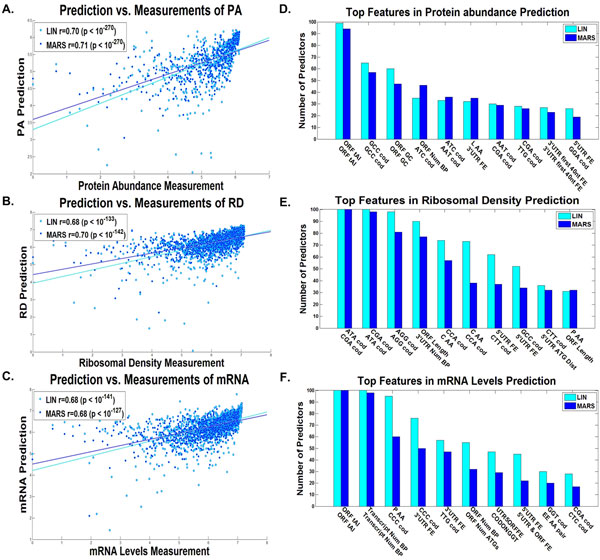
Entire Transcript linear and non-linear predictors results. Dot plot of the predictions vs. measurements for the validation set of the predictor with the median results for the A. protein levels, B. ribosomal densities, C. mRNA levels, for the entire transcript based on the, the combined linear (LIN) and non-linear (MARS) predictors (Additional file 1: Supplementary Methods). The best features according to the number of predictors they participated in (Additional file 1: Supplementary Methods) of the D. protein levels predictor, E. ribosomal density predictor, and F. mRNA levels predictor, for the entire transcript, for the combined linear (LIN) and non-linear (MARS) predictors (Additional file 1: Supplementary Methods).